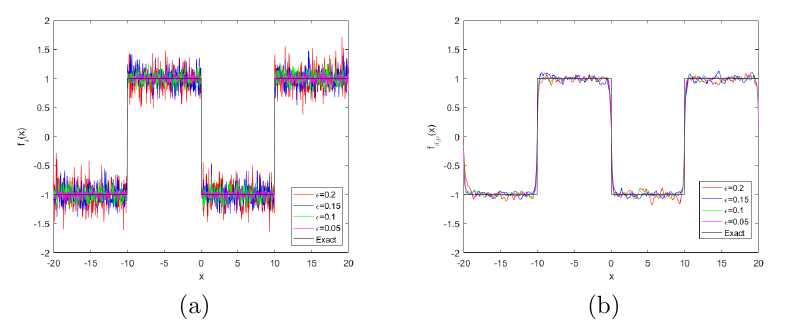
Figure 1. Sources for Example 1: unregularized (a) and regularized (b) assuming α 2 = 2 . 10 − 5 , β = 1 . 10 − 5 ,ν = 1 ,t 0 = 5 ,p = 1 and (cid:15) ∈ { 0 . 2 , 0 . 15 , 0 . 1 , 0 . 05 } .